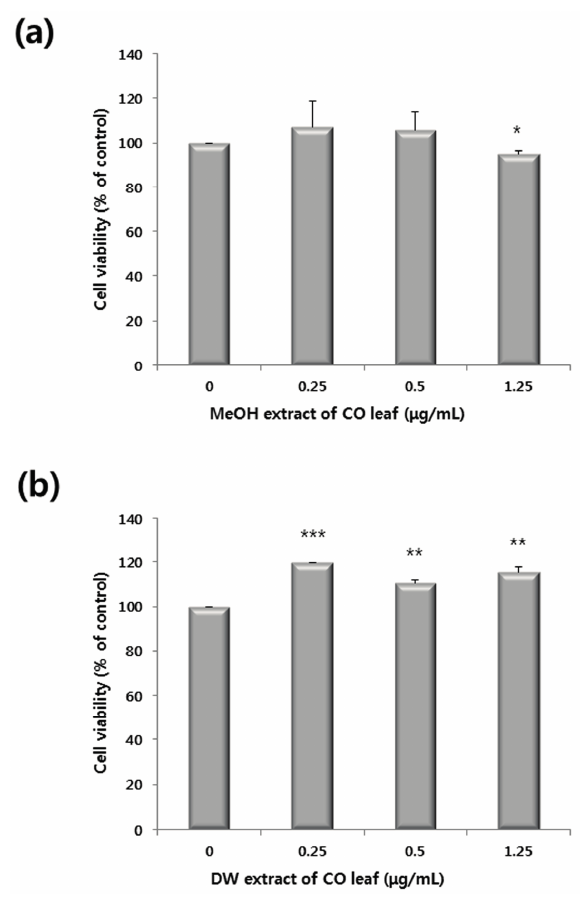
Figure 2. Cell viability of ( a ) methanol extracts and ( b ) water extracts of Chamaecyparis obtusa (CO) leaves (0–1.25 μ g/mL) against Chang liver cells. Cells were treated with the extracts for 24 h. Data represent the mean of the percentage of control in triplicate tests. * p < 0.05, ** p < 0.01 and *** p < 0.001 indicate statistically significant